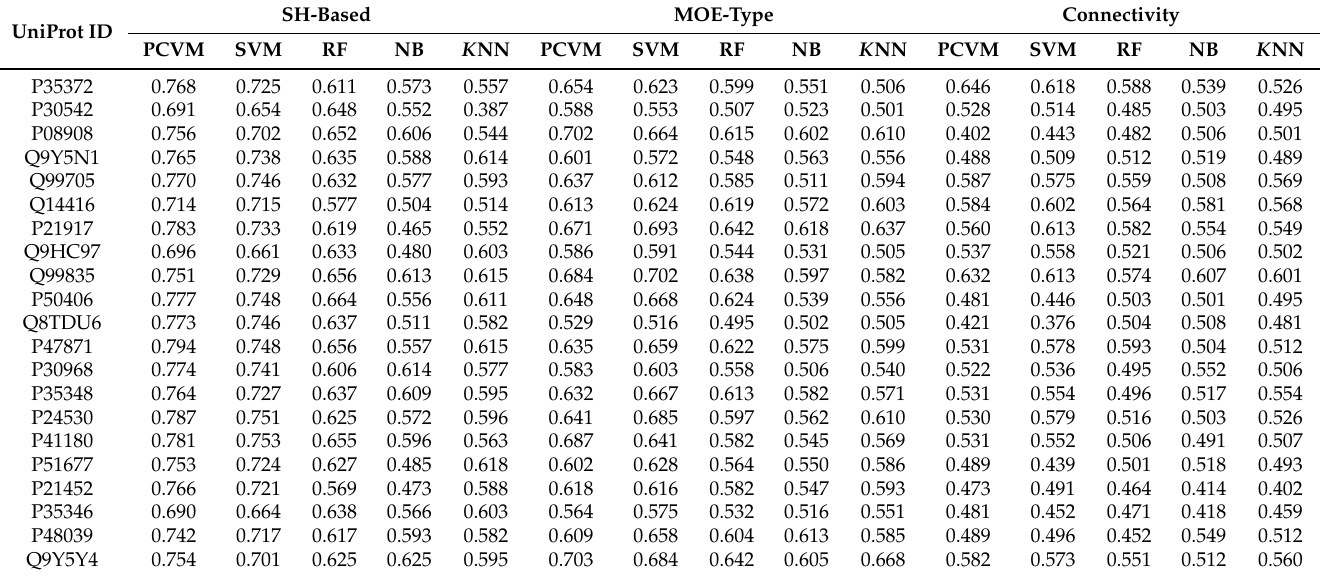
Table 8. Performance comparison of target prediction methods in terms of Matthews Correlation Coefficient. Scores for the external test